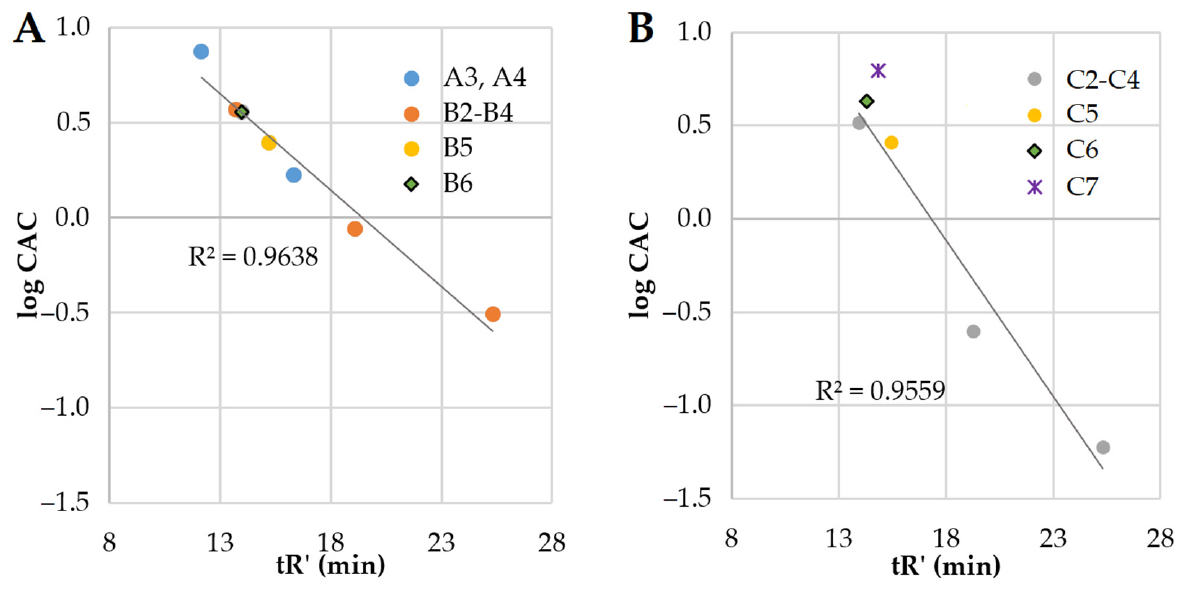
Figure 5. LogCAC vs. adjusted retention time of lipopeptides. ( A ) Series A and B (compounds A3 , A4 , B2 – B6 )—linear correlation; ( B ) Series C ( C2 – C7 )—linear correlation ( C7 was excluded).